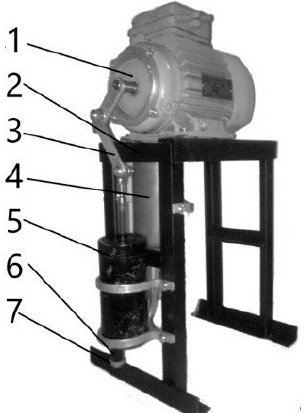
Figure 3. Experimental device for polymer cover application.